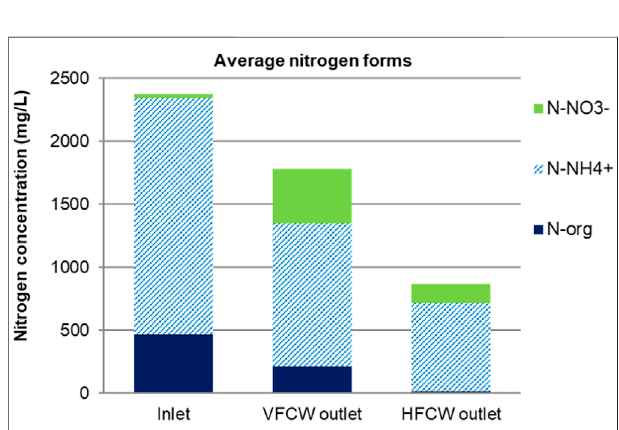
FIGURE 4 | Average nitrogen forms in the hybrid system (n (cid:2)